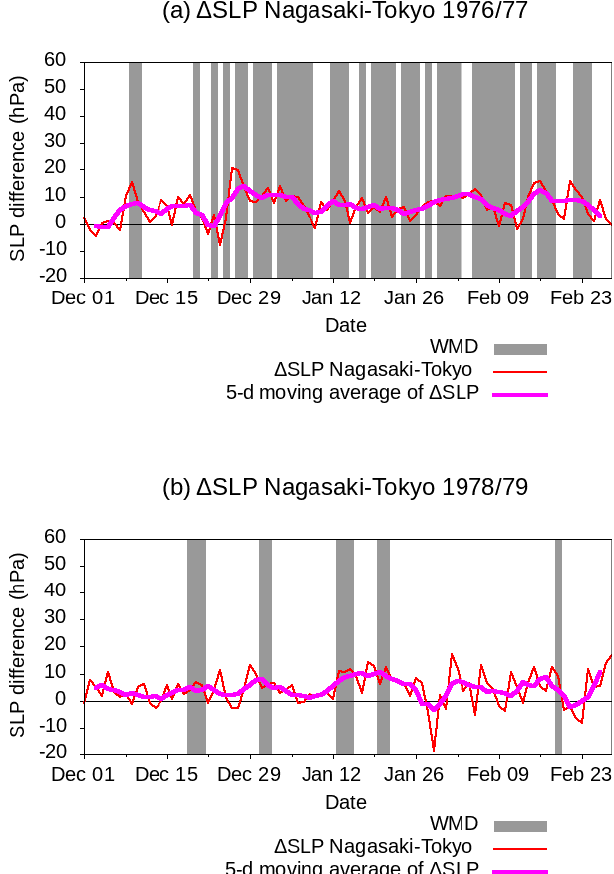
Figure 9. Temporal variations in intra-seasonal variations of east– west surface pressure differences between Beijing and Tokyo ( (cid:49) SLP B–T) and the dates of winter monsoon outbreak days (WMDs). (a) Cold winter year (1976/77) and (b) warm winter year (1978/79).